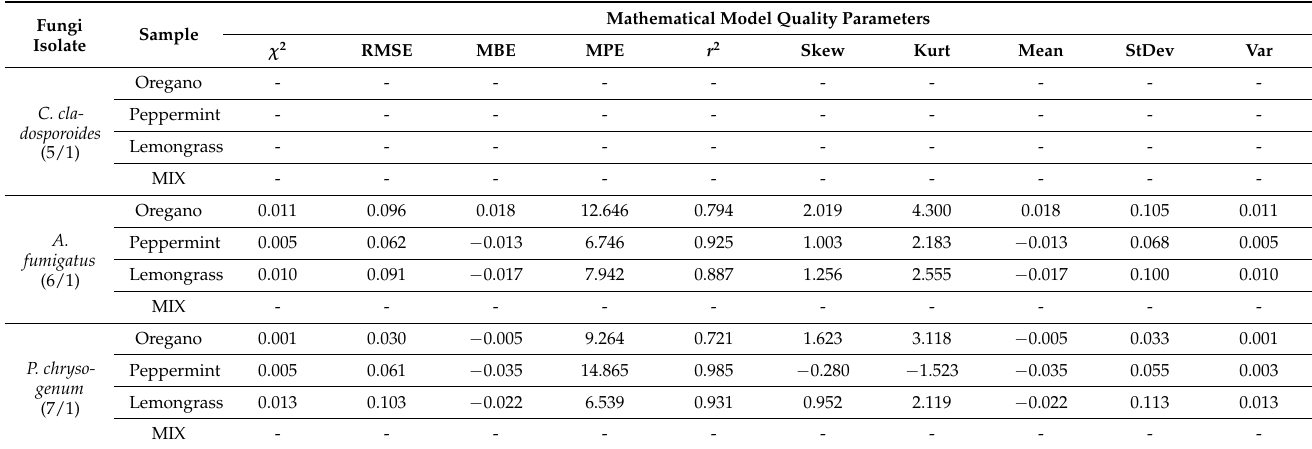
Table 8. The “goodness of fit” between experimental quantities and model planned